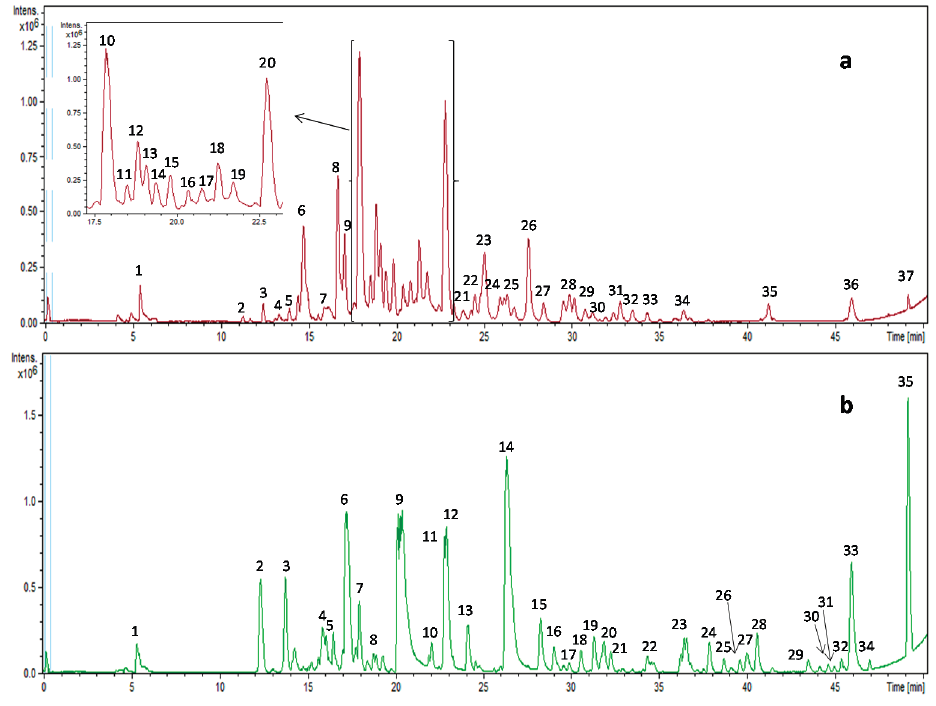
Figure 2. Base peak chromatogram of pine bark ( a ) and green tea ( b )